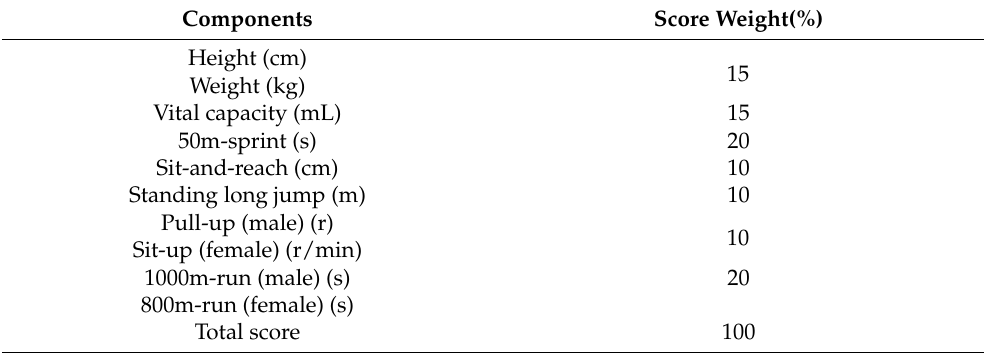
Table 1. National Student Physical Fitness Standard Test items and scoring